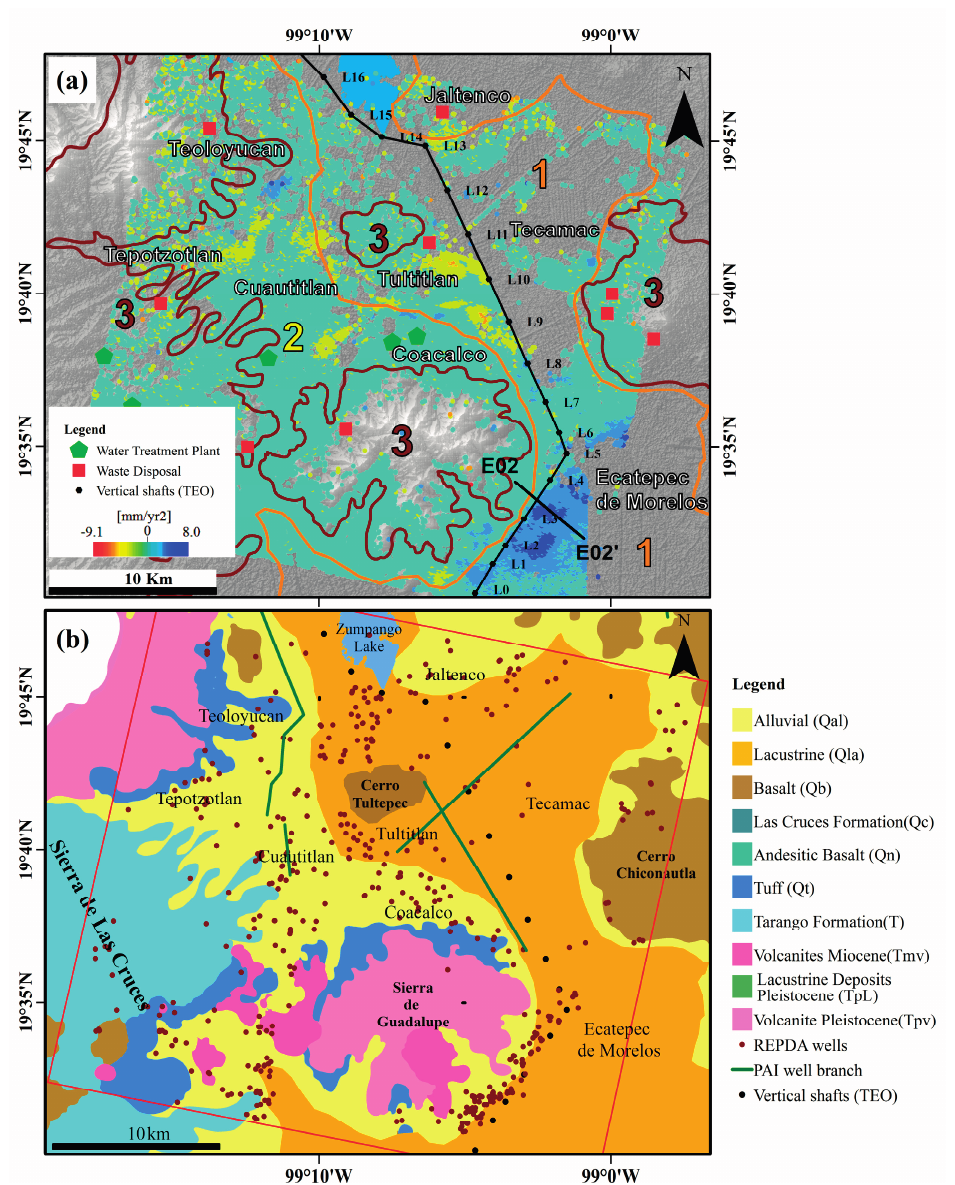
Figure 10. ( a ) Map of quadratic coefficient overlaid on SRTM V4 shaded relief.